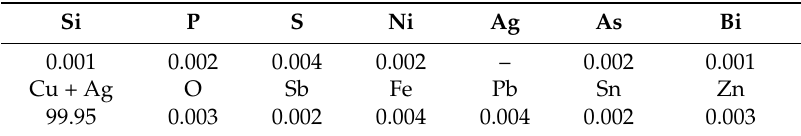
Table 1. Chemical composition of TU2 (wt.